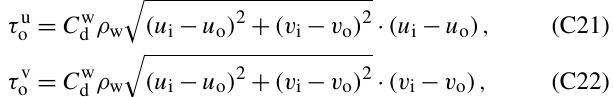
Table C1. Sea ice model parameters. Parameter Value